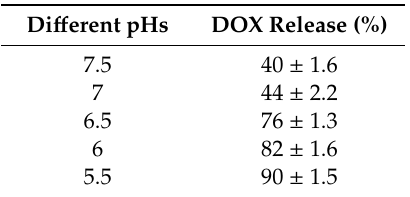
pH-dependent release of doxorubicin (DOX) from GBA suspension (0.1 mg / mL) in bicarbonated